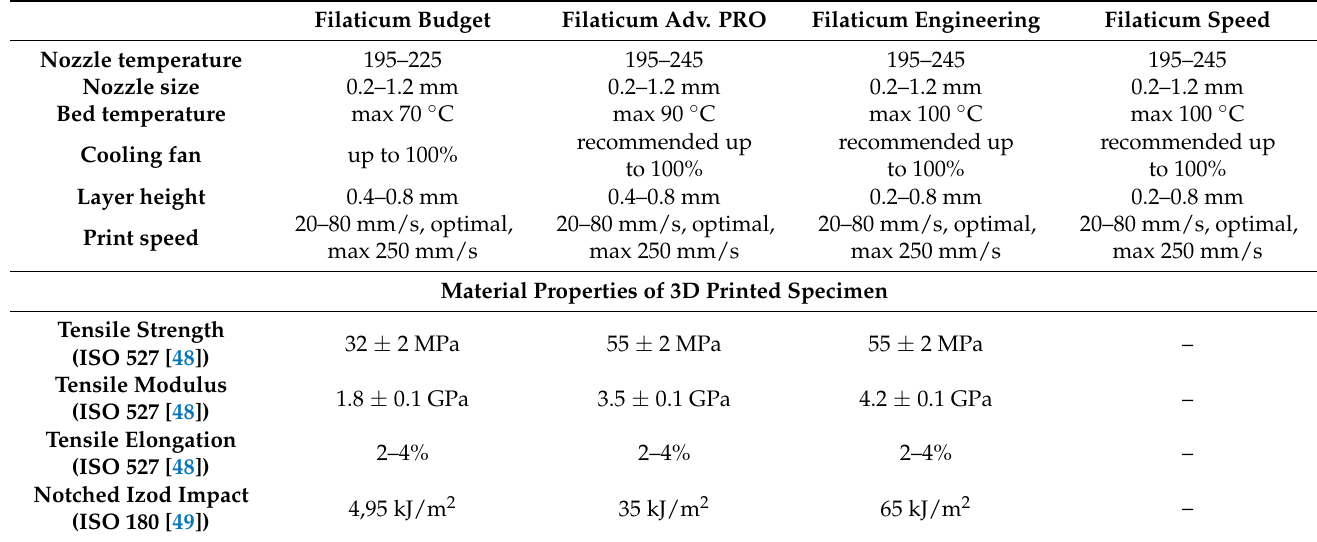
Table 3. Characteristics of the applied PLA